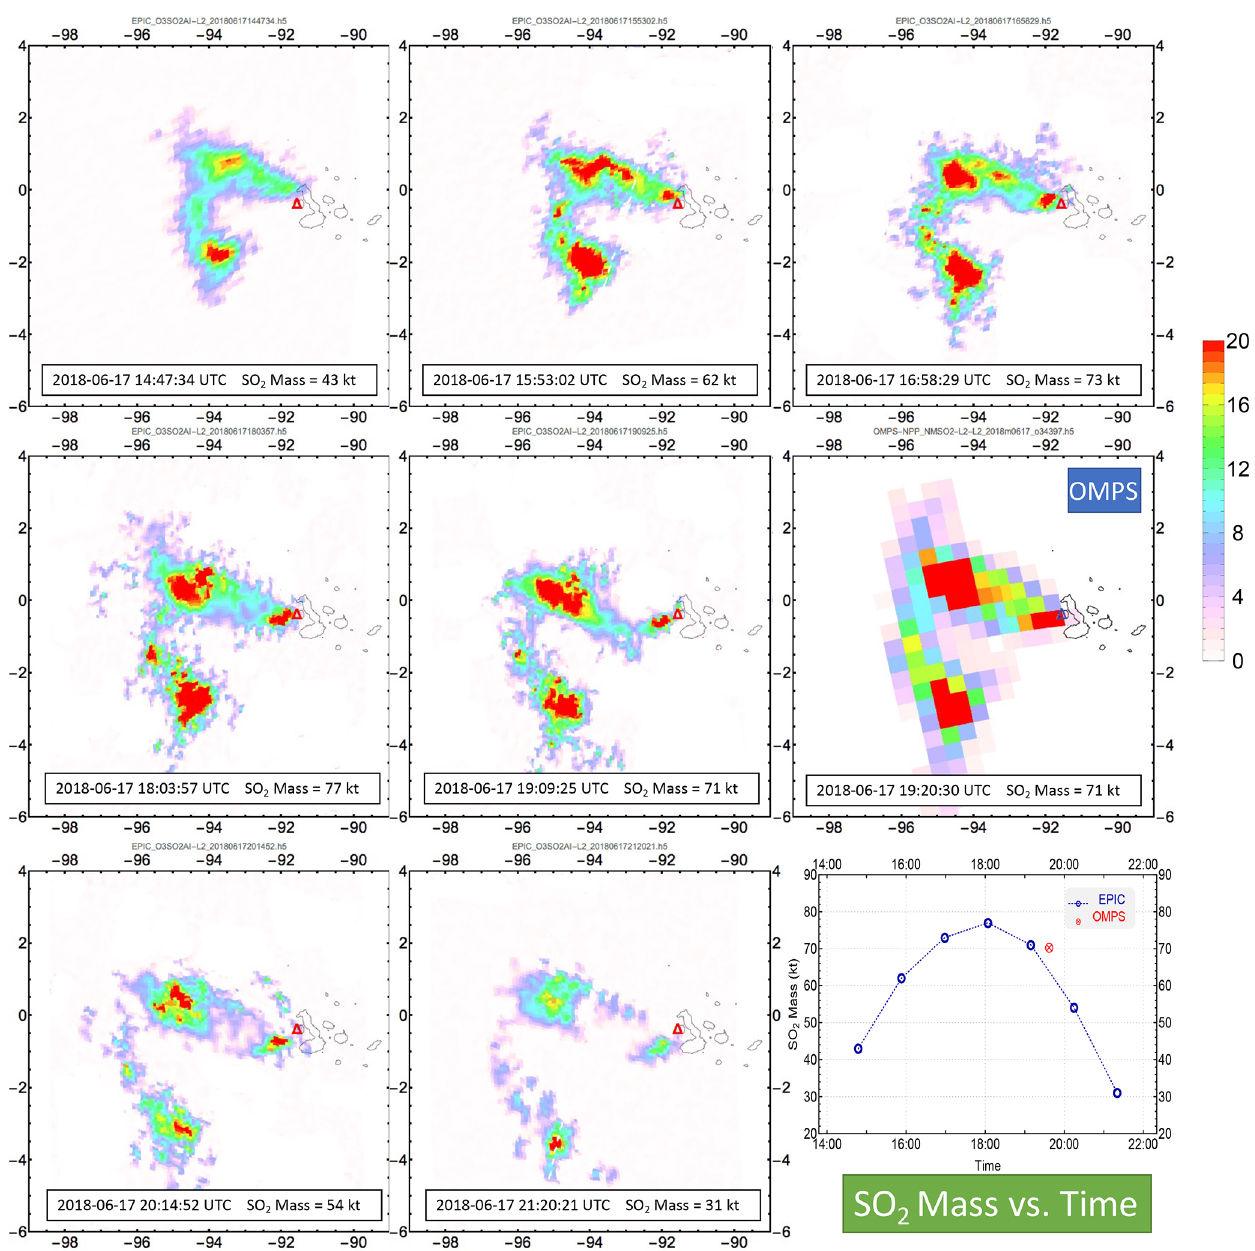
Figure 25. EPIC and OMPS observations of volcanic SO 2 plumes on 17 June 2018 from the eruption of Fernandina volcano ( (cid:49) ) in the Galapagos Islands. This eruption injected a significant amount of SO 2 into the troposphere at about 3.5km above sea level. The mass loading of an SO 2 plume is obtained by summing the SO 2 masses of all IFOVs with SO 2 vertical columns ≥ 1DU. The lower right panel plots the EPIC and OMPS SO 2 masses vs. the observation time